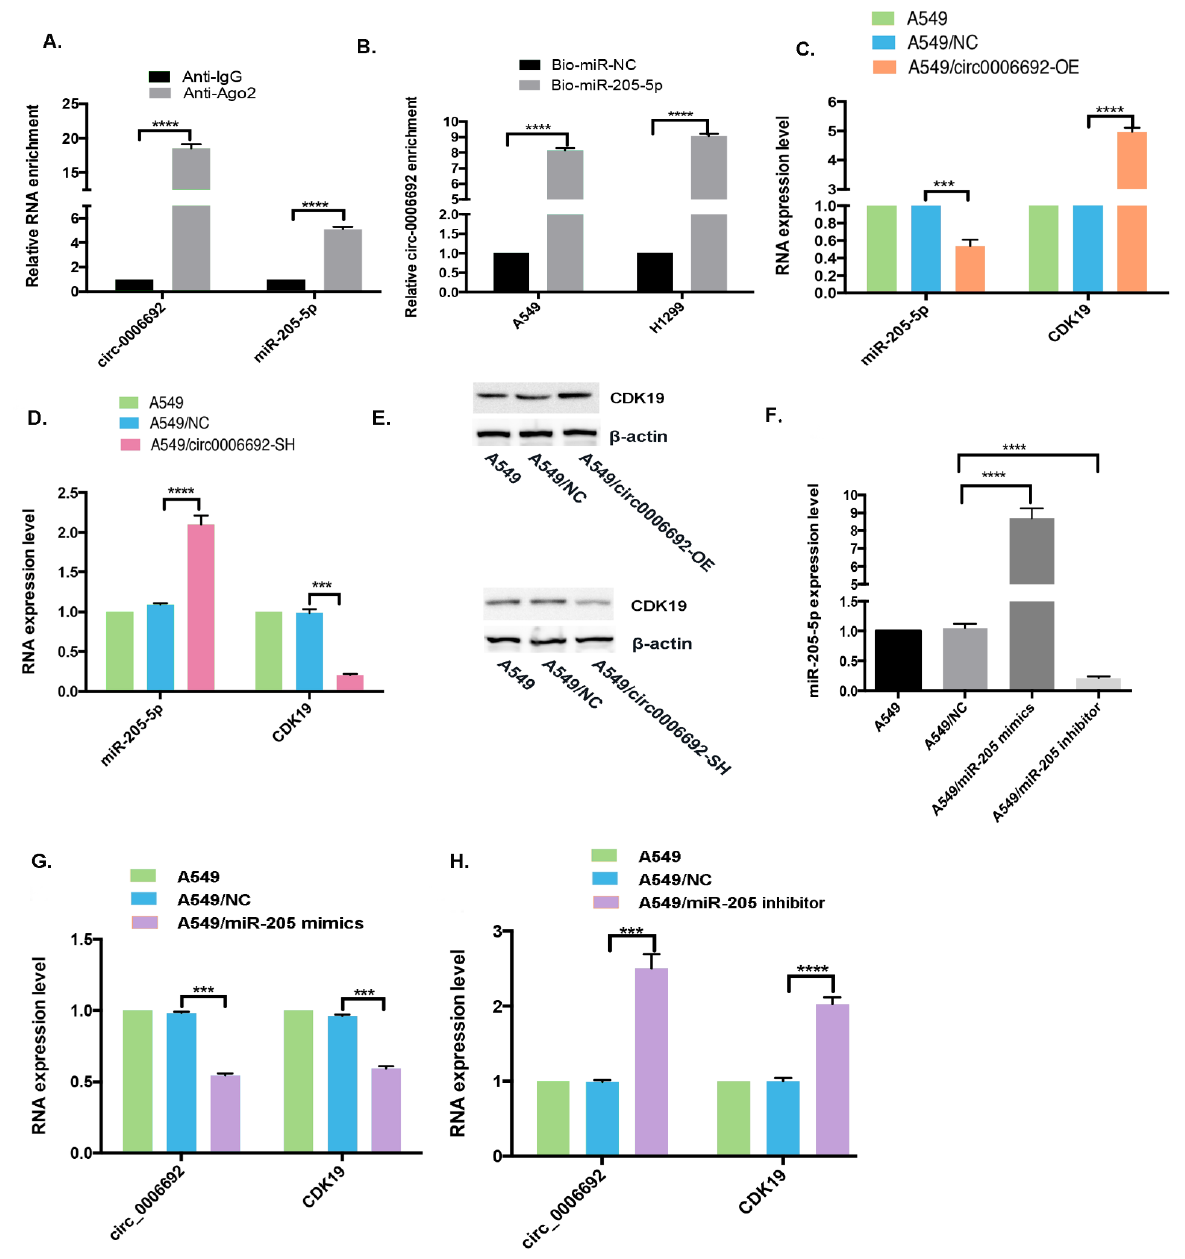
Figure 4. hsa_circ_0006692 played its roles via sponging hsa-miR-205-5p and regulation of CDK19. ( A ) After the detection of ago2 or IgG RIP assay, hsa_circ_0006692 and miR-205-5p levels was determined by qRT-PCR; ( B ) After RNA pull-down analysis using Bio-miR-NC and Bio-miR-205-5p in A549 and H1299 cells, expression of hsa_circ_0006692 was measured by qRT-PCR; ( C – E ) CDK19 expression level was increased in A549/circ-0006692-OE cells and decreased in A549/circ-0006692-SH cells analyzed by qRT-PCR and WB; ( C , D ) miR-205-5p expression was decreased in A549/circ-0006692-OE cells and increased in A549/circ-0006692-SH cells analyzed by qRT-PCR; ( F ) miR-205-5p expression in A549 cells transfected with miR-205-5p mimics or inhibitors was analyzed using qRT-PCR; ( G , H ) qRT-PCR analysis of hsa_circ_0006692 and CDK19 expression in A549 cells transferred with miR-205-5p mimics or inhibitor. *** p < 0.001; **** p < 0.0001.